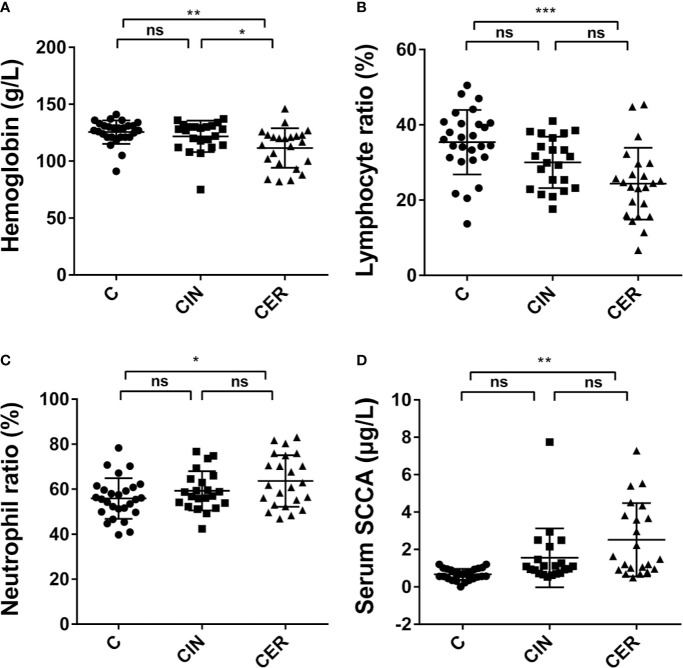
Differences in clinical blood test indicators. In the comparison of neutrophil ratio (C) (P = 0.0249) and squamous cell carcinoma antigen (SCCA) (D) (P = 0.0001), CER group is higher than CIN group, and CIN group is much higher than C group. To the contrary, the hemoglobin (A) (P = 0.0024) and lymphocyte ratio (B) (P < 0.0001) in C group is much higher than CIN group and CER group. P value less than 0.05 is statistically significant. * means p < 0.05; * means P < 0.01; ** means P < 0.001; *** means P < 0.001; p < 0.05 indicates significant difference. C, Control group, a group of women who have no problem in gynecology; CER, Cervical cancer group, a group of women who were diagnosed a cervical cancer by pathological biopsy; CIN, Cervical intraepithelial neoplasis group, a group of women who were diagnosed by pathological biopsy or cytological test; ns, not significant.